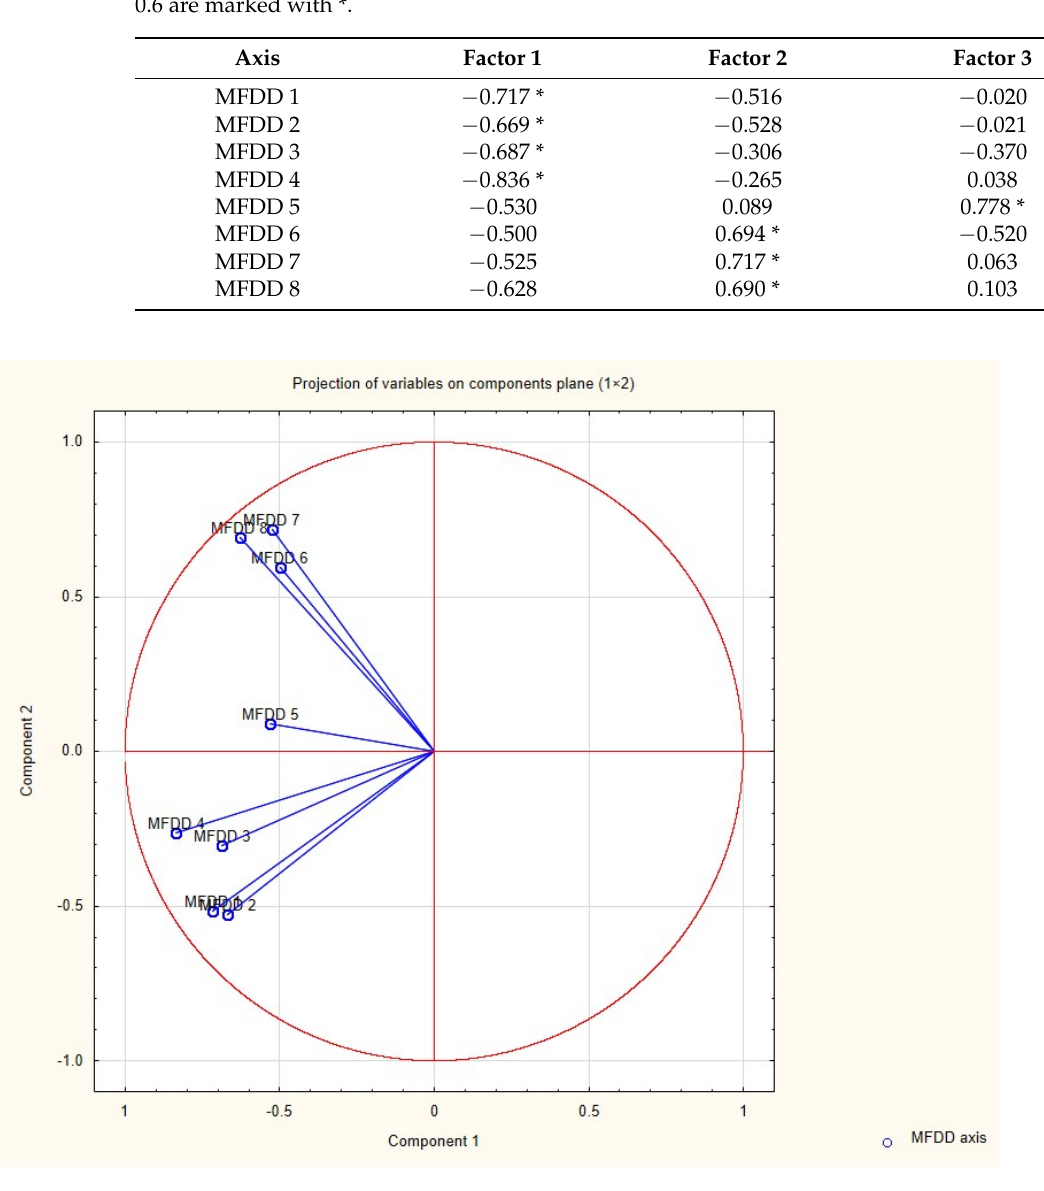
Figure 2. Loading plot. Plane defined by the first two components. Axes described by correlation value (factor load of the variable).